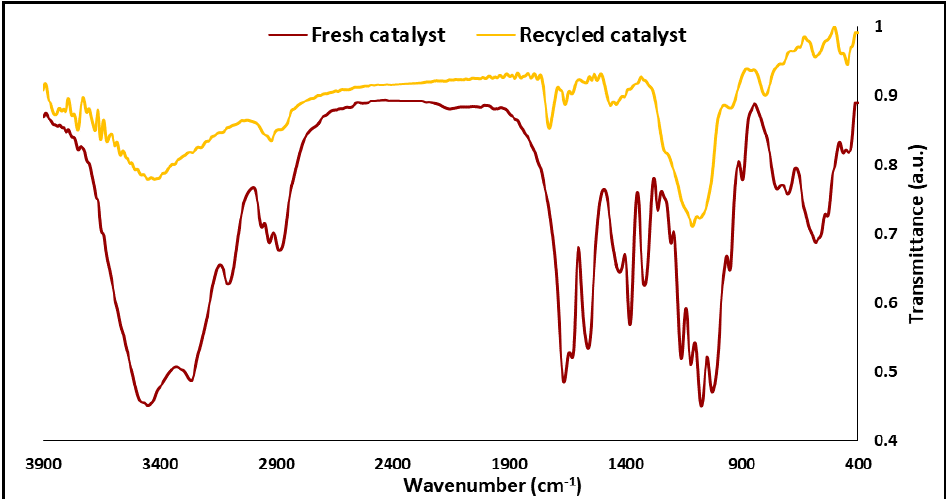
Figure 9. Comparison of FTIR spectrum of the recycled Ag@CDNS-N / PMelamine after five reaction runs with that of the fresh catalyst.